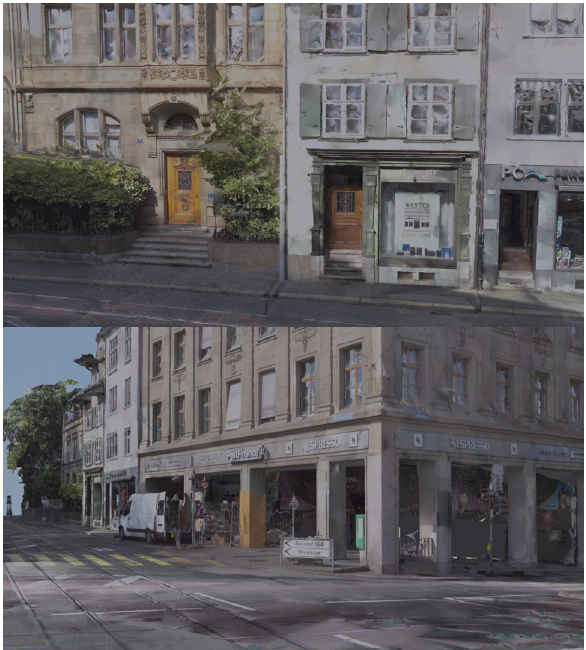
Figure 10. Samples of the reconstructed 3D city